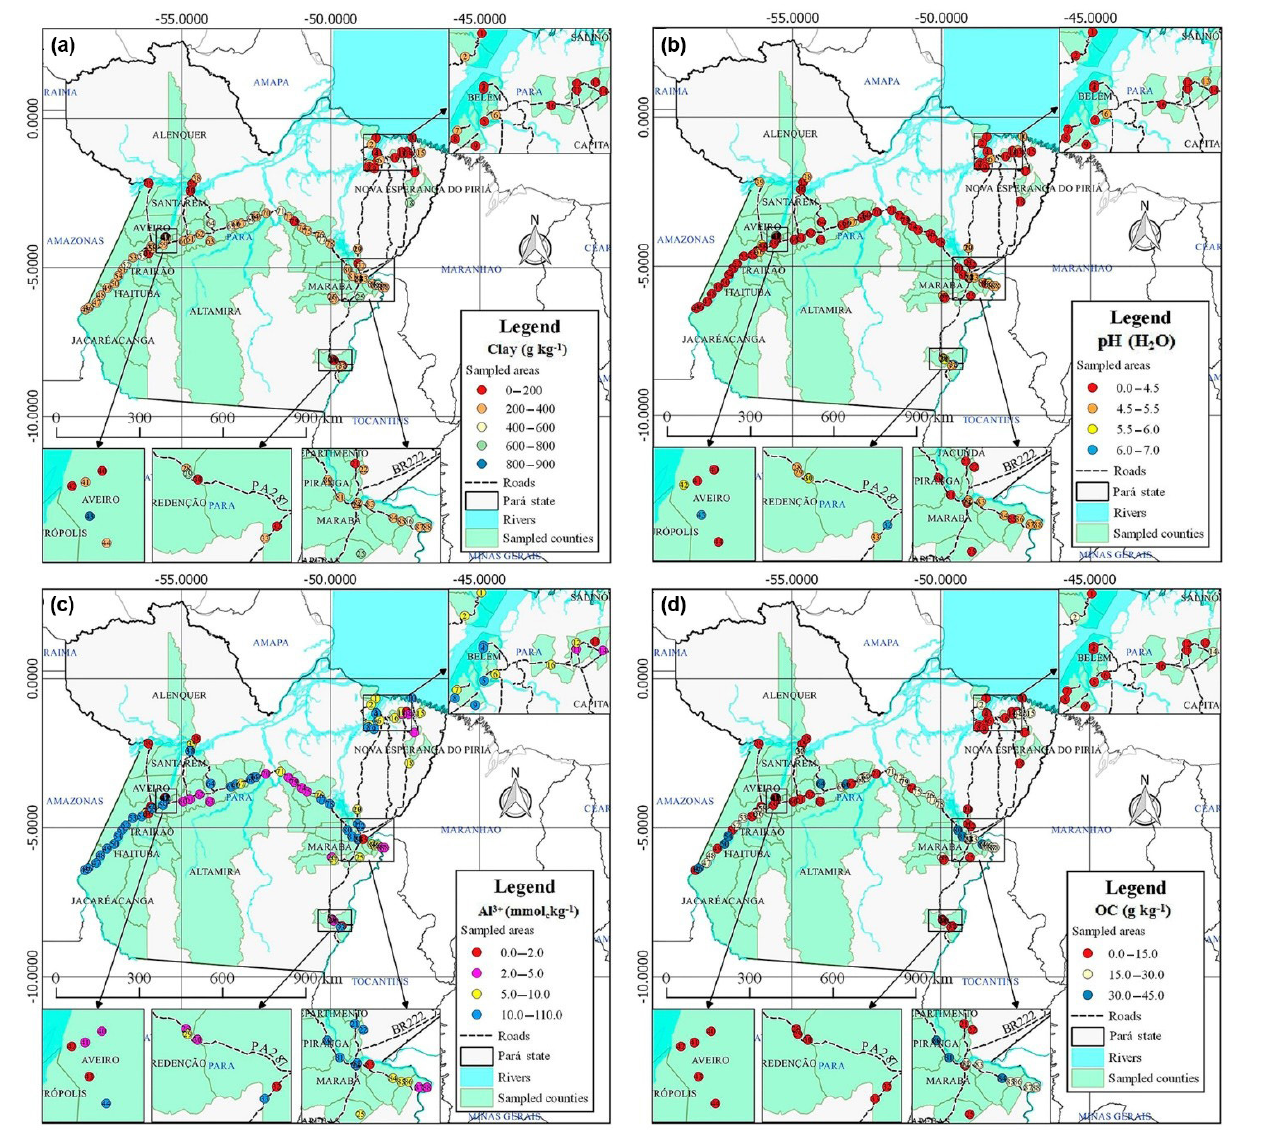
Figure 4. Spatial distribution map of clay (a) , pH (b) , Al 3 + (c) , and organic carbon (OC) (d) of the soils of the state of Pará.